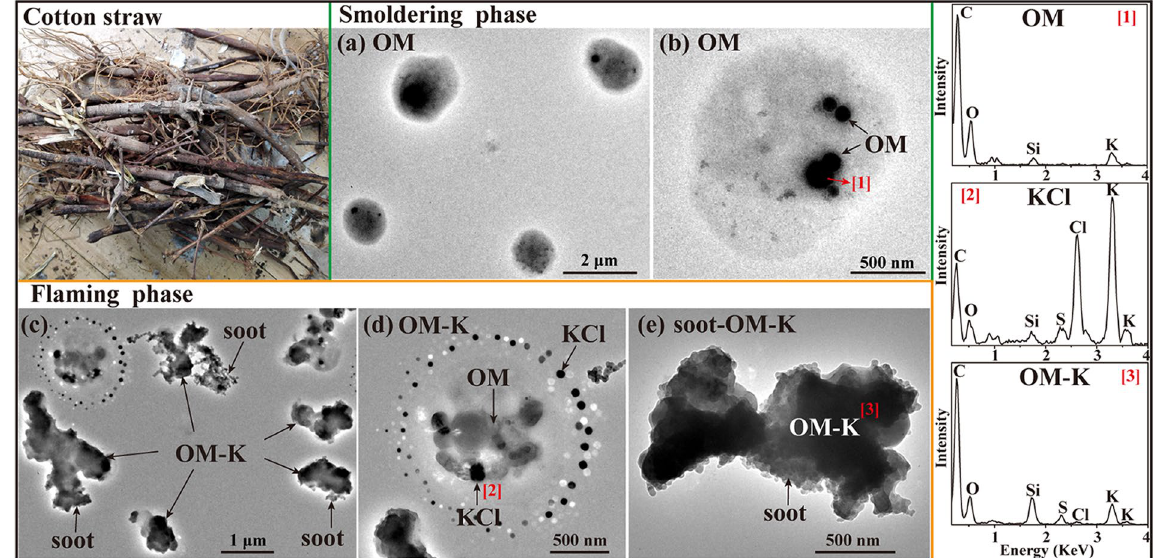
Figure 3. TEM images and EDS spectra of individual primary particles from the combustion of cotton straw. ( a ) Low magnification TEM image of gel-like OM in the smoldering phase; ( b ) A gel-like and transparent OM particle with dark and spherical OM inclusions in the smoldering phase; ( c ) Low magnification TEM image of a mixture of OM-K and soot-OM-K in the flaming phase; ( d ) An OM particle internally mixed with KCl and externally mixed with satellite ring of tiny KCl particles in the flaming phase; ( e ) An OM particle internally mixed with soot in the flaming phase. The corresponding EDS spectra are indicated by the number in square